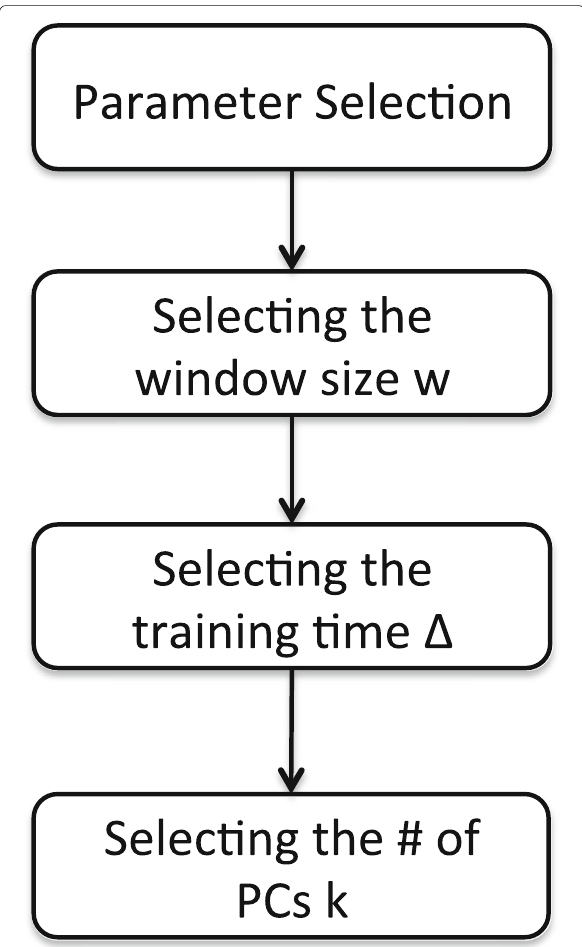
Fig. 10 Process for selecting parameters: window size w , training time (cid:2) , and number of PCs